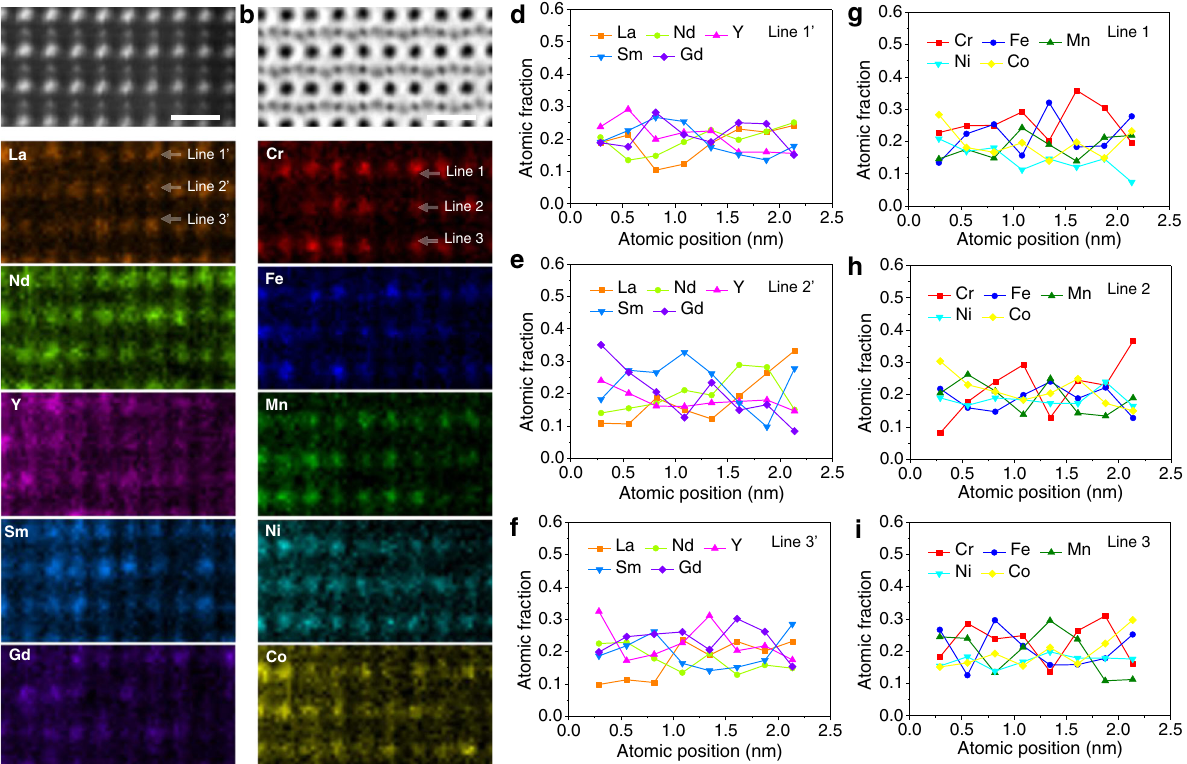
Fig. 3 Atomic structure and compositional fl uctuation of (5RE0.2)(5TM0.2)O3. a HAADF-STEM and b ABF images of (5RE 0.2 )(5TM 0.2 )O 3 taken from [110] zone axis. Scale bar is 0.5 nm. c Atomic EDS mapping showing the disordered elemental distribution in the B-site of the ABO 3 structure. Line pro fi les of the atomic fraction calculated from the relative intensity fraction, representing the distribution of individual ( d – f ) A-site and ( g – i ) B-site elements in a (001) plane projected along the [110] zone